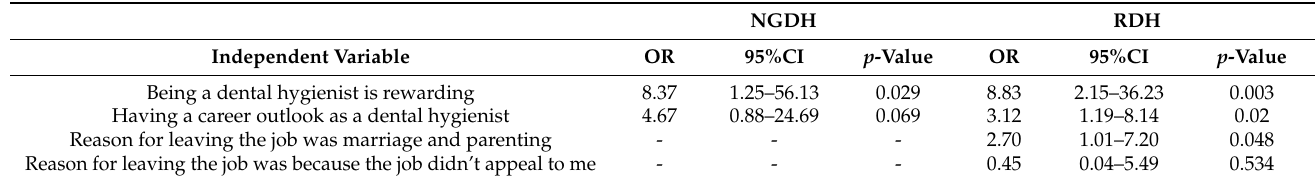
Table 3. Multiple logistic regression analysis showing the proportion of those with the intention to continue in the